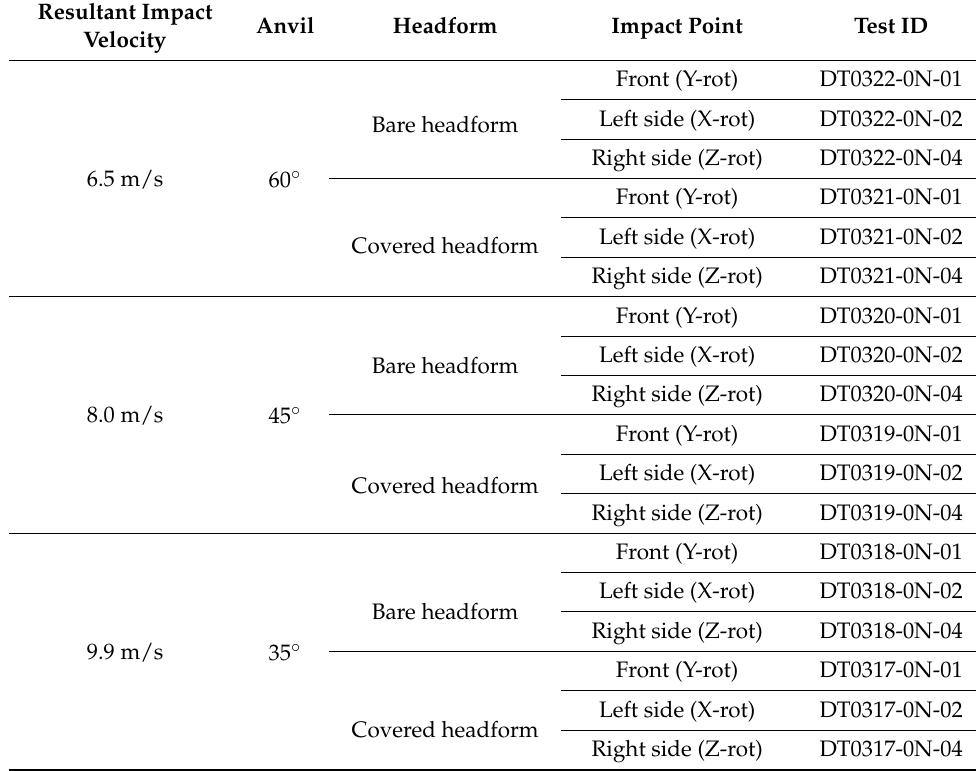
Table 1. Test matrix. For N from 1 to 3, indicating repeated tests for a particular